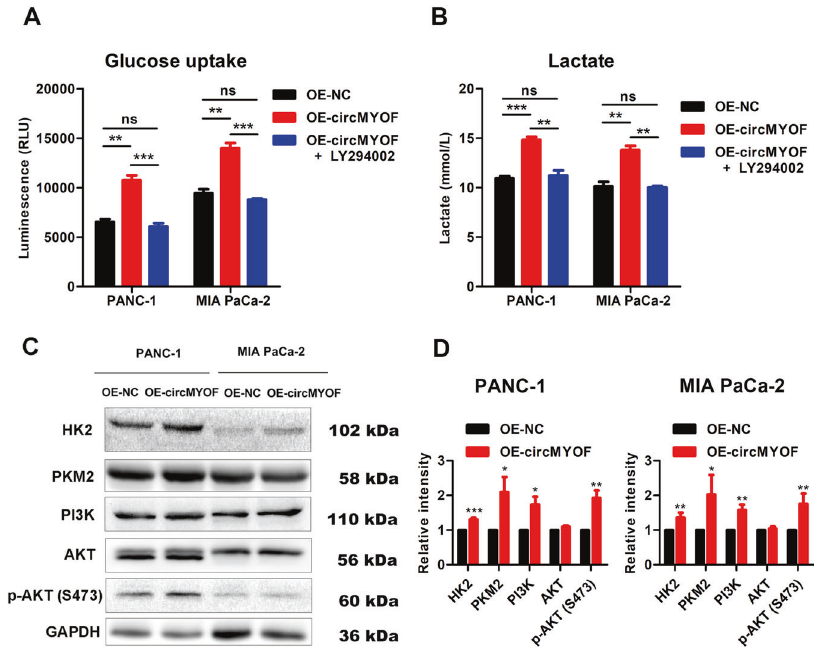
Fig. 5 CircMYOF facilitates glycolysis via the PI3K/AKT pathway in PDA. A, B Overexpression of circMYOF enhanced glucose uptake ( A ) and lactate production ( B ), and LY294002 counteracted the enhancing effect of circMYOF. C, D Representative images of western blotting in PANC- 1 and MIA PaCa-2 cells of circMYOF overexpression groups ( C ) and quanti fi cation using ImageJ software ( D ). Data were shown as the mean ± SD. All experiment was conducted in triple. * p < 0.05, ** p < 0.01 and *** p <